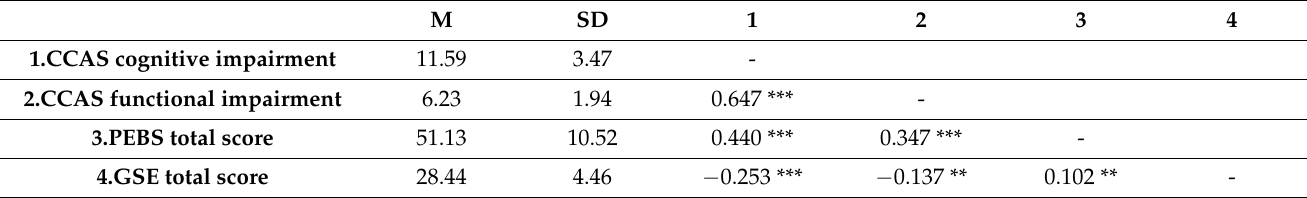
Table 2. Age- and sex-adjusted partial correlation coefficients between the analysed variables are shown.